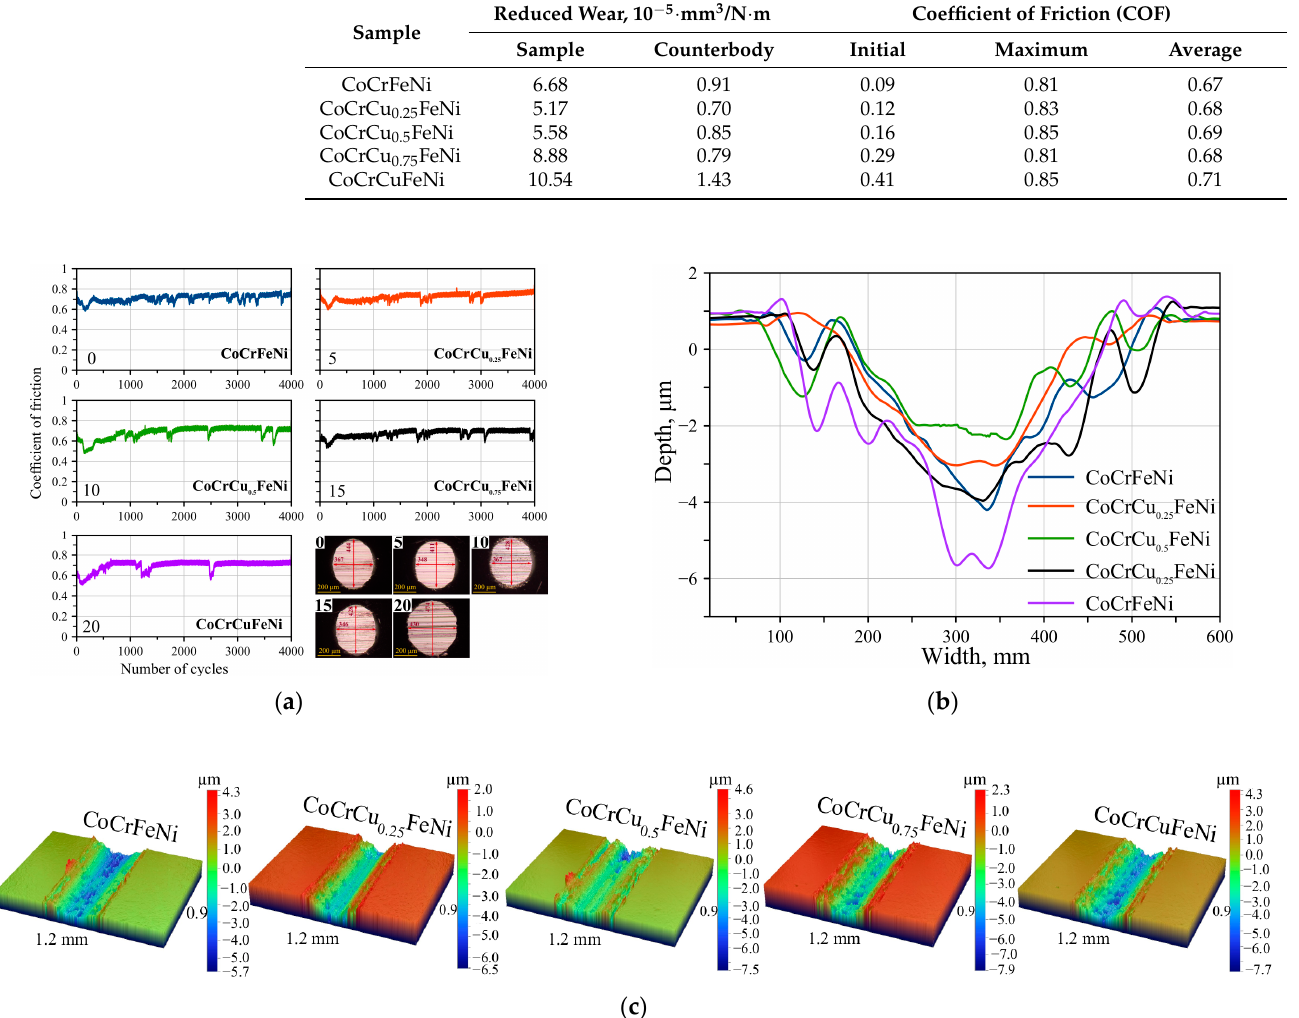
Figure 5. ( a ) The coefficient of friction as a function of the number of cycles (the counterbody wear is shown in the inset); ( b ) wear track profiles for the CoCrCu x FeNi samples and ( c ) 3D images of the wear tracks.